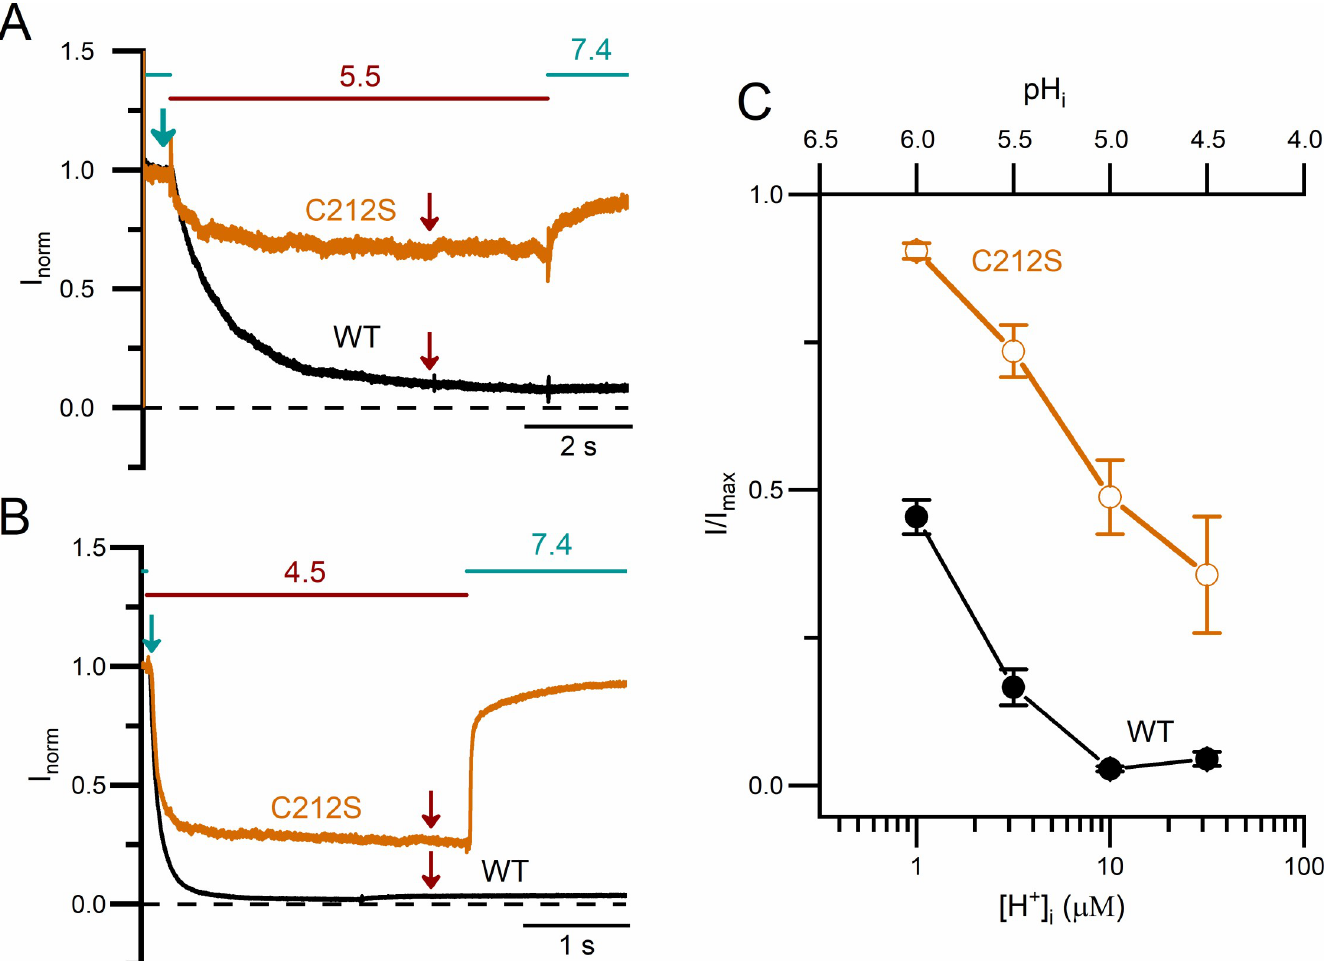
Fig 6. Comparison of low pH i -induced inhibitions between WT CLC-0 and the C212S mutant. (A) Current inhibition of WT CLC-0 and C212S mutant at +20 mV by pH i = 5.5. (B) Current inhibition of WT CLC-0 and C212S mutant at +20 mV by pH i = 4.5. (C) Remaining current fraction ( I/I max ) of WT CLC-0 and C212S mutant against [H + ] i (or pH i ) (n = 4–7). The steady-state current (I) was measured, respectively, at 5 s and 3 s (indicated by wine-colored arrows in A & B, respectively) after applying the pH i 5.5 and pH i 4.5 solutions. I max was the current measured immediately before the low-pH i solution was applied (teal color arrows in A & B).